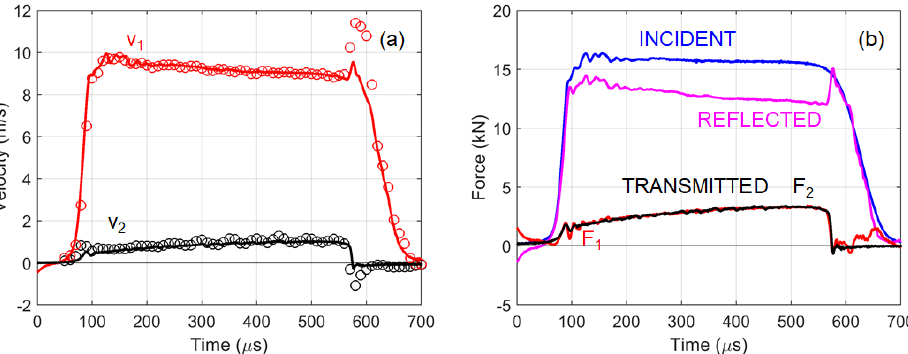
Fig. 4. High strain rate test at 1000 °C on HT specimen: (a) comparison of the input and output sides velocity time history profiles obtained by video analysis (markers) and strain-gage signal processing (solid lines); (b) check of the equilibrium condition between input and output sides of the specimen.